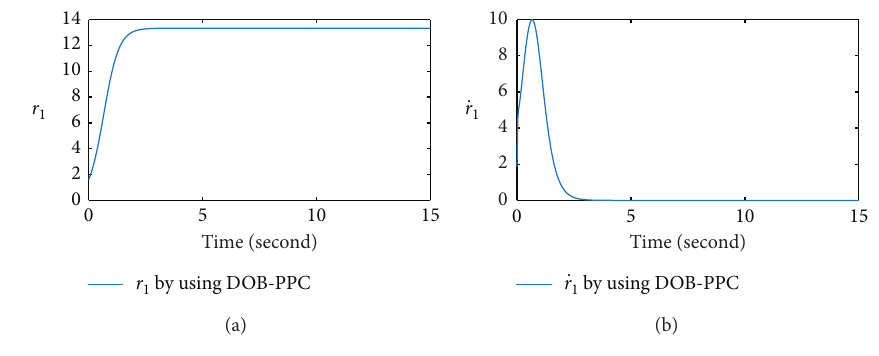
Figure 5: Time response of (a) r